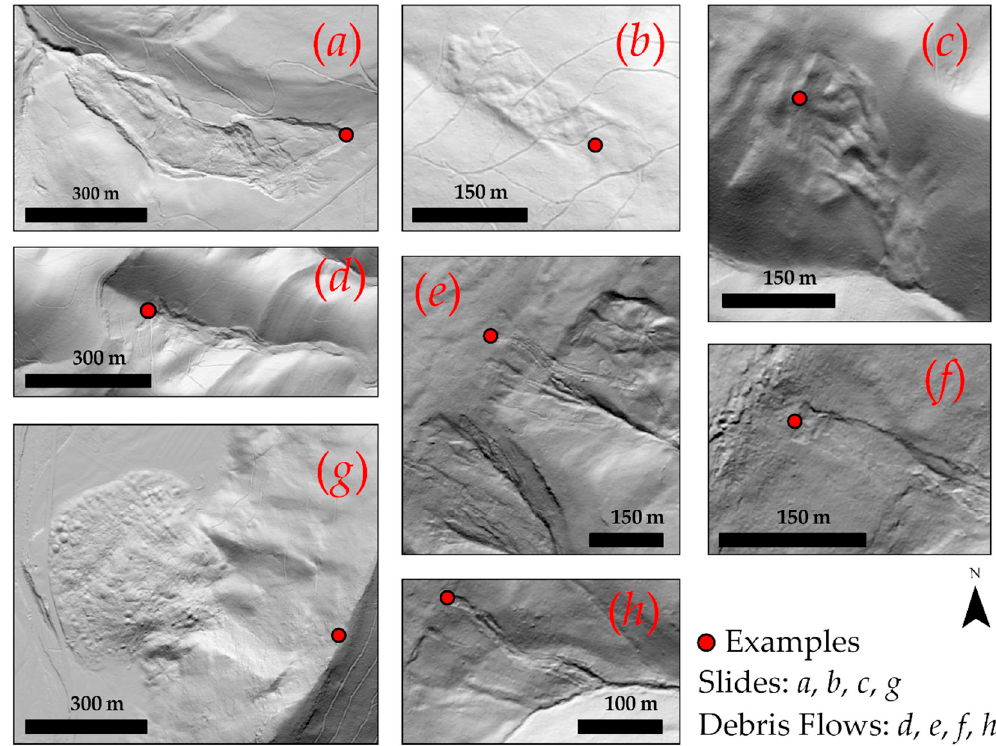
Figure 2. Example slope failure initiation points used to train the model. The hillshade was created from a 1 m resolution LiDAR-derived digital terrain model (DTM).